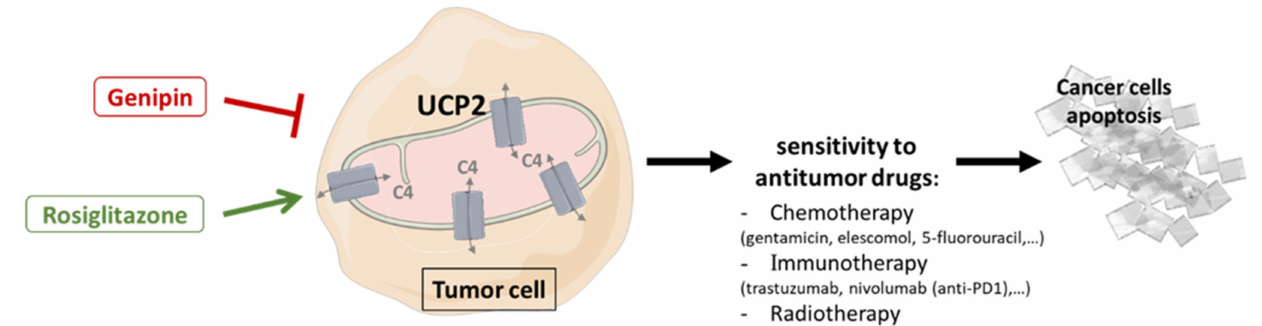
Figure 3. Therapeutic strategies targeting UCP2 combined with antitumor therapies to promote cancer cell apoptosis. Use of activators (rosiglitazone) or inhibitors (Genipin) of UCP2, depending on tumor-dependent metabolism, leads to changes in the capacities of mitochondria to provide energy and building blocks through the transport of 4-carbon tricarboxylic acid cycle metabolites, and may improve sensitivity to anticancer therapies by increasing tumor cell apoptosis. C4: 4-carbon metabolites; UCP2: uncoupling protein